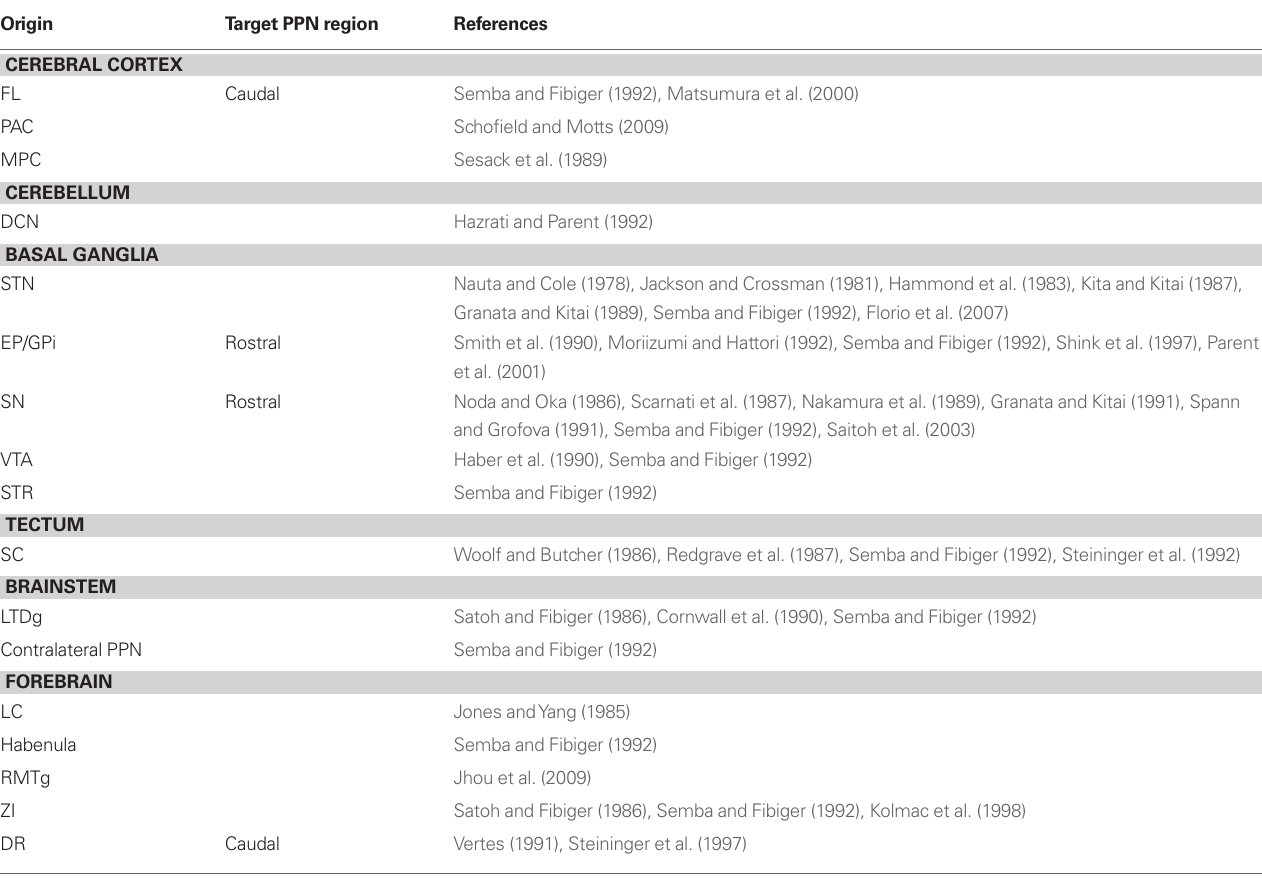
Table 2 | afferent connectivity of the pedunculopontine